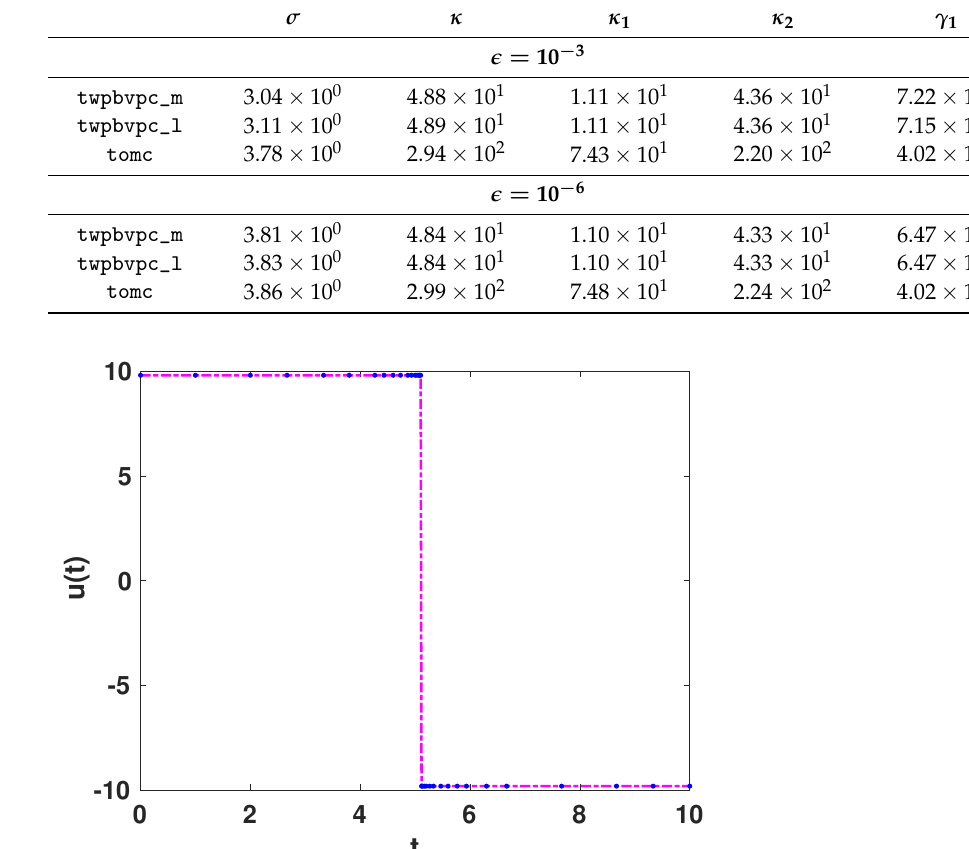
Table 17. Longitudinal dynamics of a vehicle T = 10, g = 9.81, k 0 = 0.02 g , k 1 = 10 − 5 g , k 2 = 0, k 3 = 0: conditioning parameters computed using tol = 10 − 6 .